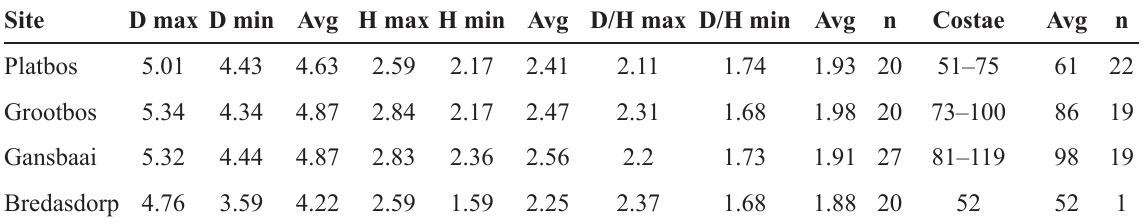
Table 4. Measurements of Chondrocyclus kevincolei sp. nov., showing variation between populations; D = shell diameter, H = height, costae = number of axial ribs on body whorl, Avg = average.